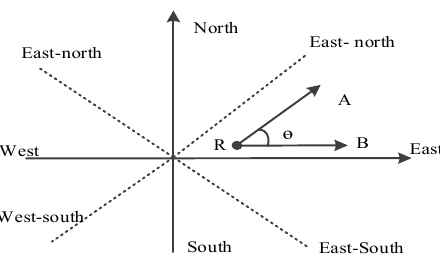
Figure 3. Direction relations